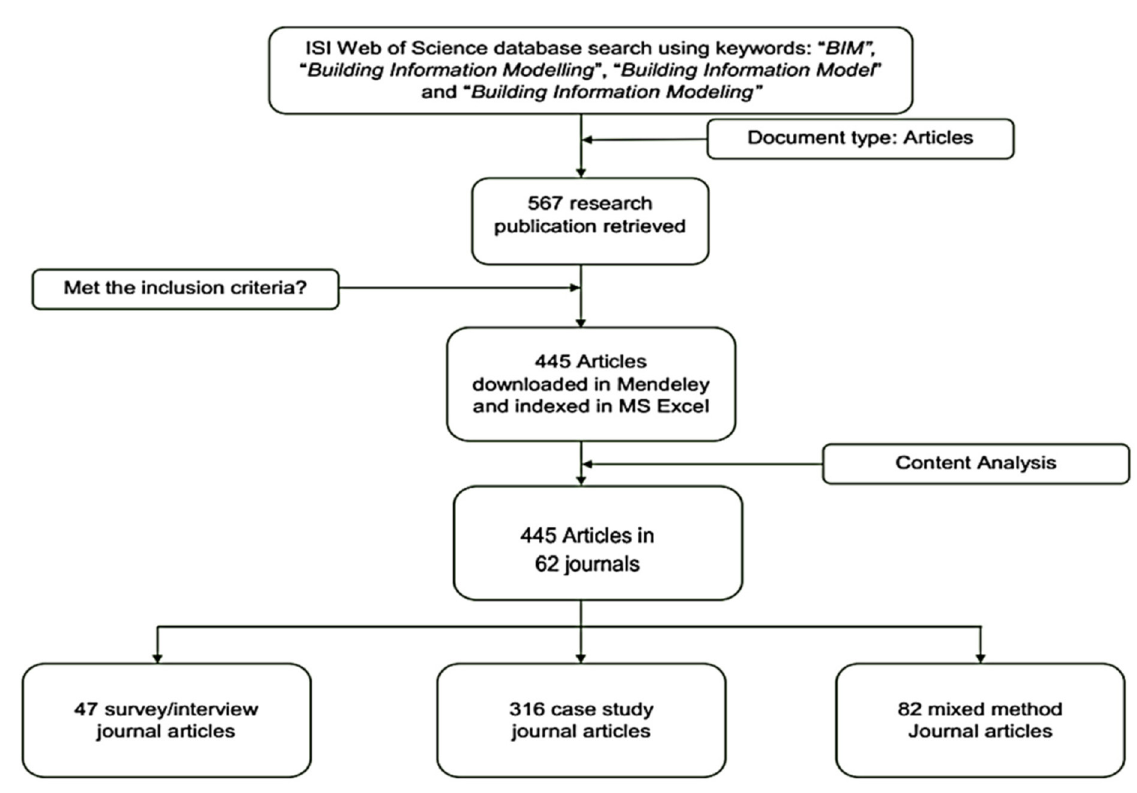
Fig. 2. Literature search and indexing